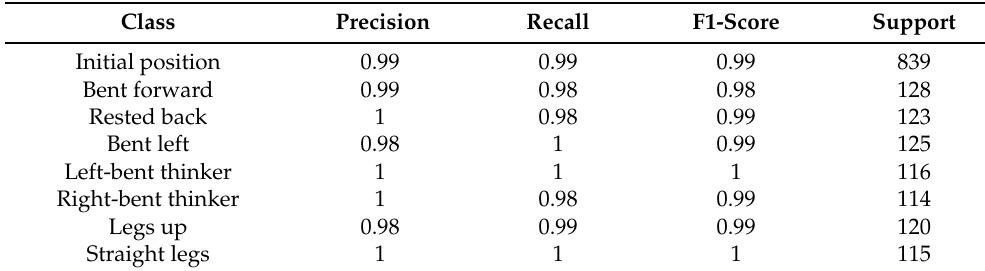
Table 4. Accuracy results of the FCN for all the sitting